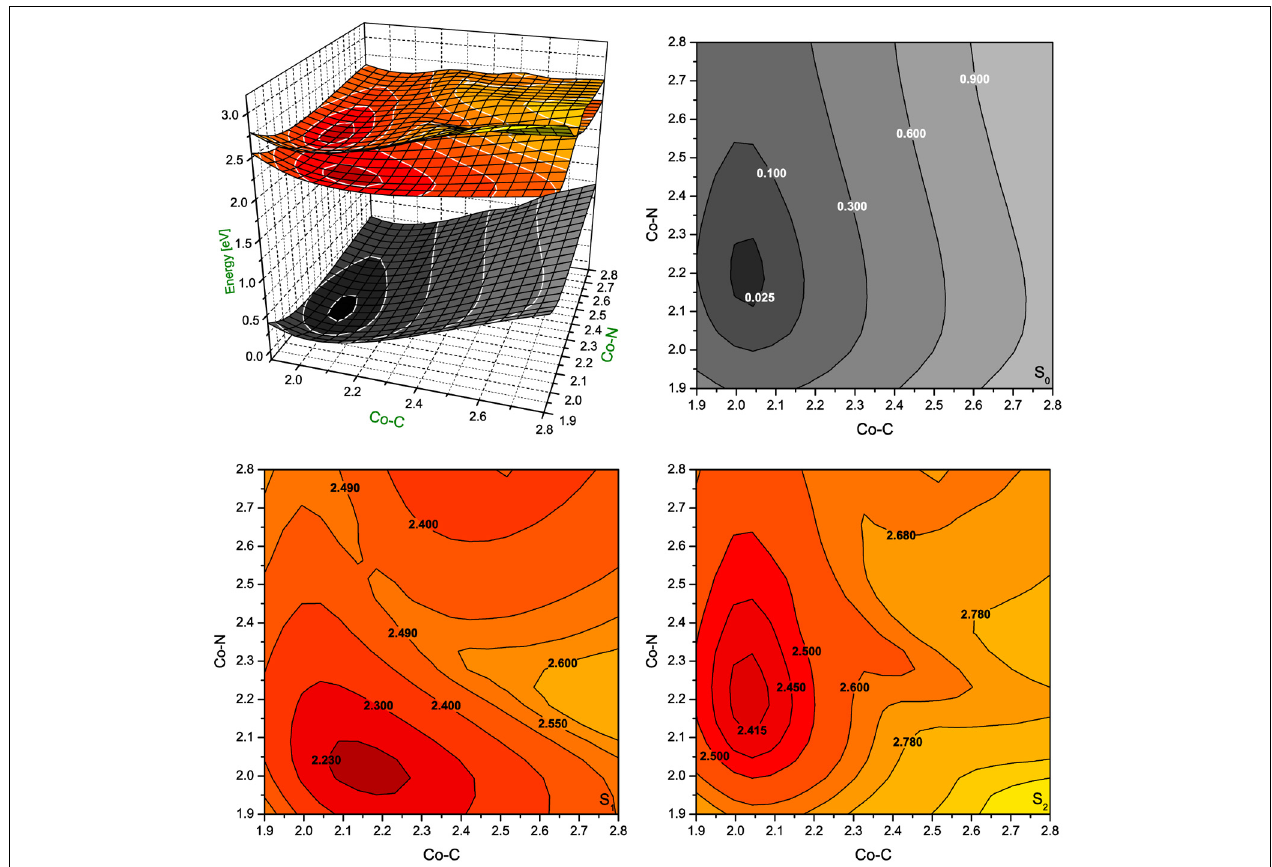
FIGURE 6 | Potential energy surfaces for singlet ground state and two lowest singlet excited states of RibCbl together with their vertical projections plotted as a function of axial bond lengths (expressed in Å) calculated in water solution (PCM) with BP86/TZVP.